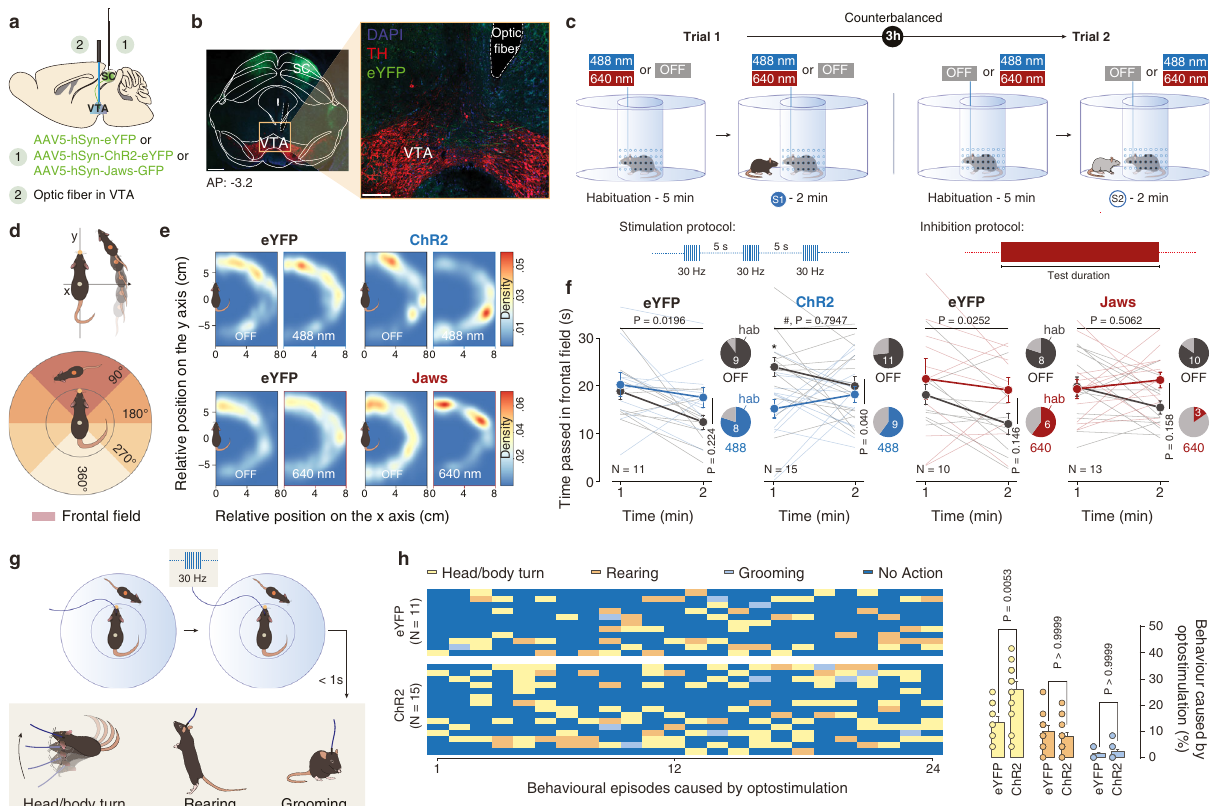
Fig. 3 Optogenetic manipulation of SC-VTA pathway alters orienting response. a Schema of injections sites in SC with AAV5-hSyn-eYFP, AAV5-hSyn- ChR2-eYFP, or AAV5-hSyn-Jaws-GFP, and optic fi ber implantation above the VTA. b Representative image of coronal midbrain slices of adult mice infected with AAV5-hSyn-eYFP (green) in the SC. In red is visible the immunostaining anti-Tyrosine Hydroxylase (TH) (Left panel: scale bar = 500 µ m. Right panel: image at higher magni fi cation, scale bar = 100 µ m). Similar viral expression and OF location were observed in all the mice that performed the experiment described in Figs. 3c, 5b. c Top panel: Schema of the social orientation test. The eYFP-, ChR2- and Jaws-expressing mice oriented towards two different unfamiliar mice under both stimulation conditions. Bottom left panel: Stimulation and inhibition protocols. 8 pulses of 488 nm light (30 Hz) were separated by 5 s in the light ON condition. Bottom right panel: Continuous inhibition was instead provoked with 640 nm light. d Upper panel: schema representing the relative position of the social stimulus when the center body point of the experimental animals is fi xed at (0, 0) and the nose point is fi xed along the y -axis. Lower panel: schema representing the position of the frontal fi eld. e Heatmaps reporting the relative position of the social stimulus during orientation test for the 1st and 2nd minute in the different conditions. f Time passed with the social stimulus in the frontal fi eld for the 1st and 2nd minute of the social orienting test in light and no-light conditions. RM two-way ANOVA (eYFP 488 nm : Light main effect: F (1,10) = 1.683, P = 0.2236; Time main effect: F (1,10) = 7.711, P = 0.0196; Light × Time Interaction: F (1,10) = 1.254, P = 0.2890. ChR2: Light main effect: F (1,14) = 5.138, P = 0.0398; Time main effect: F (1,14) = 0.070, P = 0.7947; Light × Time Interaction: F (1,14) = 4.868, P = 0.0446. eYFP 640 nm : Light main effect: F (1,9) = 2.537, P = 0.1456; Time main effect: F (1,9) = 7.185, P = 0.0252; Light × Time Interaction: F (1,9) = 0.6144, P = 0.4533. Jaws: Light main effect: F (1,12) = 2.266, P = 0.1581; Time main effect: F (1,12) = 0.4696, P = 0.5062; Light × Time Interaction: F (1,12) = 4.572, P = 0.0538) followed by Bonferroni ’ s multiple comparisons post-hoc test. Pie charts represent the percentage of mice that decrease the orientation between 1st and 2nd minute. g Possible behaviors caused by the optostimulation and observed less than 1 sec after a burst of light. h Left panel: identi fi cation and report of the behavioral episodes caused by optostimulation. Right panel: quanti fi cation of the behavioral episodes caused by optostimulation. Two-way ANOVA (Behavior main effect: F (1.874,43.09) = 60.95, P < 0.0001; Group main effect: F (1, 23) = 3.684, P = 0.0674; Behavior × Group Interaction: F (2, 46) = 11.29, P = 0.0001) followed by Bonferroni ’ s multiple comparisons post-hoc test. N indicates the number of mice. # indicates signi fi cantly different interaction. All the data are shown as the mean ± s.e.m. as error bars. Source data are provided as a Source Data fi